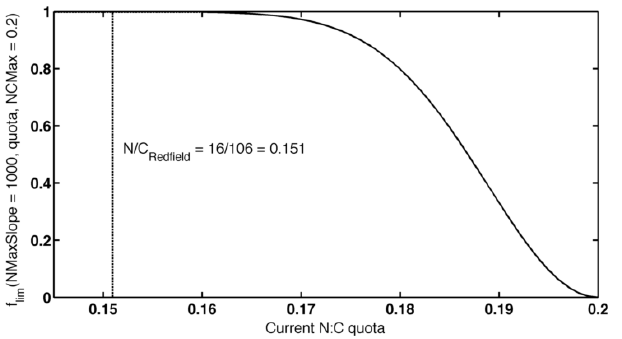
Figure A2. Change in limiter function f N:Cmax